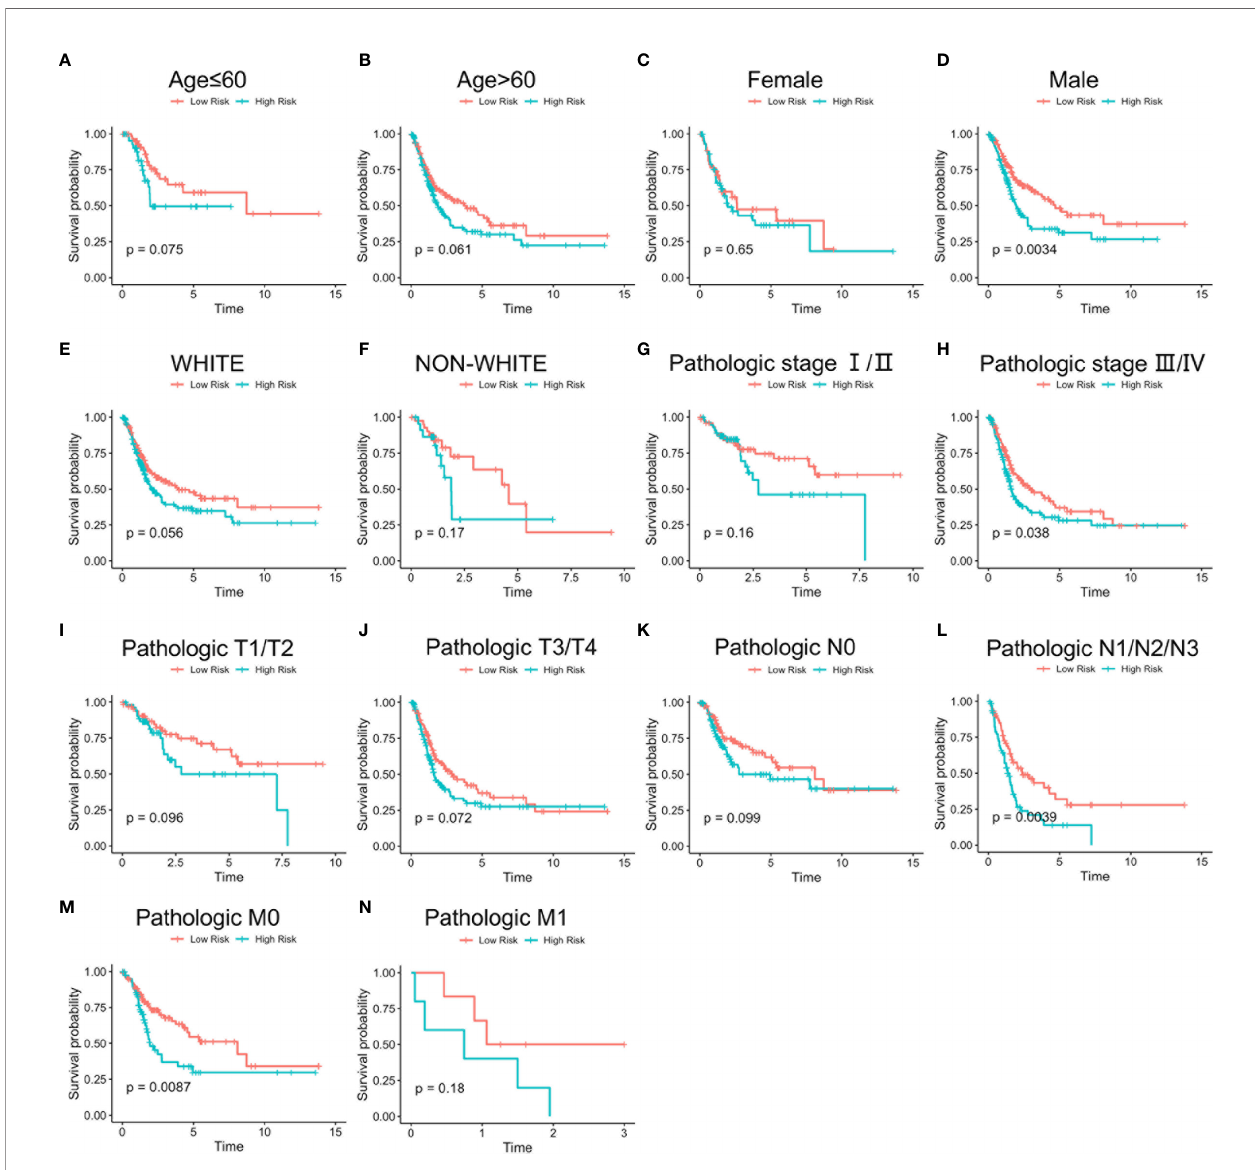
FIGURE 8 | Strati fi ed survival analysis based on clinical characteristics. Overall survival analysis of age ≤ 60 (A) , age > 60 (B) , female (C) , male (D) , White (E) , non-White (F) , pathologic stage I/II (G) , pathologic stage III/IV (H) , pathologic T1/T2 (I) , pathologic T3/T4 (J) , pathologic N0 (K) , pathologic N1/N2/N3 (L) , pathologic M0 (M) , and pathologic M1 (N) patients according to risk score. Time: